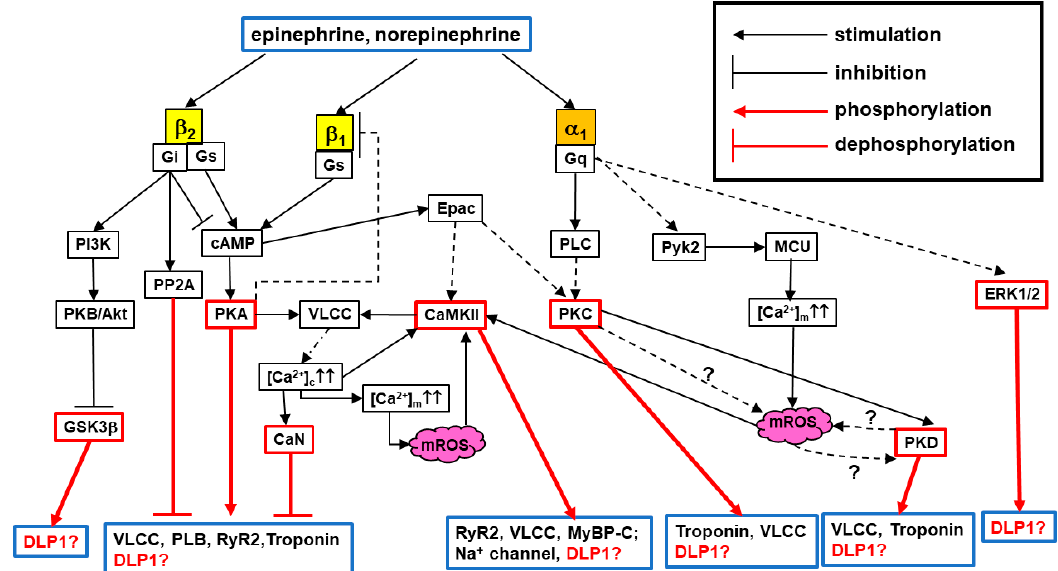
Figure 1. Overview of adrenergic signaling pathways in cardiomyocytes: Schematic diagram of cardiac AR subtypes and their downstream signaling. α 1 -AR consists of three highly homologous subtypes, including α 1A -, α 1B -, and α 1D -AR, but we only show the downstream pathways from the main subtype in CMs, α 1A -AR, in this diagram. Major Ca 2+ handling proteins are also shown as the substrates for the downstream kinases of ARs. Dot lines indicate the pathways with multiple steps that are abbreviated in this scheme. Dot lines with “?” indicate the pathways with less evidence from publications, but highly promising pathways. PI3K, phosphoinositide 3-kinase; PLC, phospholipase C; PKB, protein kinase B; Pyk2, Protein tyrosine kinase 2; Epac, exchange factor directly activated by cAMP; MyBP-C, myosin-binding protein C; PP2A, Protein phosphatase 2; mROS, mitochondrial ROS; GSK3 β , glycogen synthase kinase 3 β ; CaN, calcineurin.